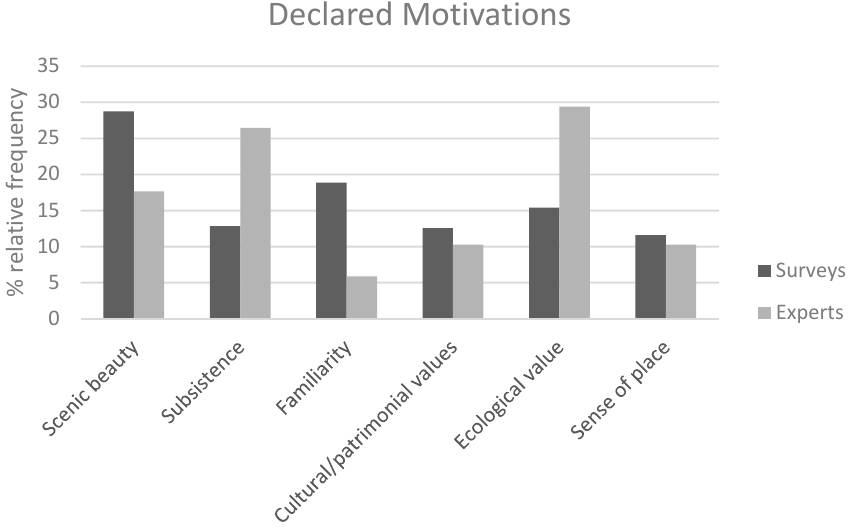
Figure 3. Relative frequencies of declared motivations in landscape preferences.